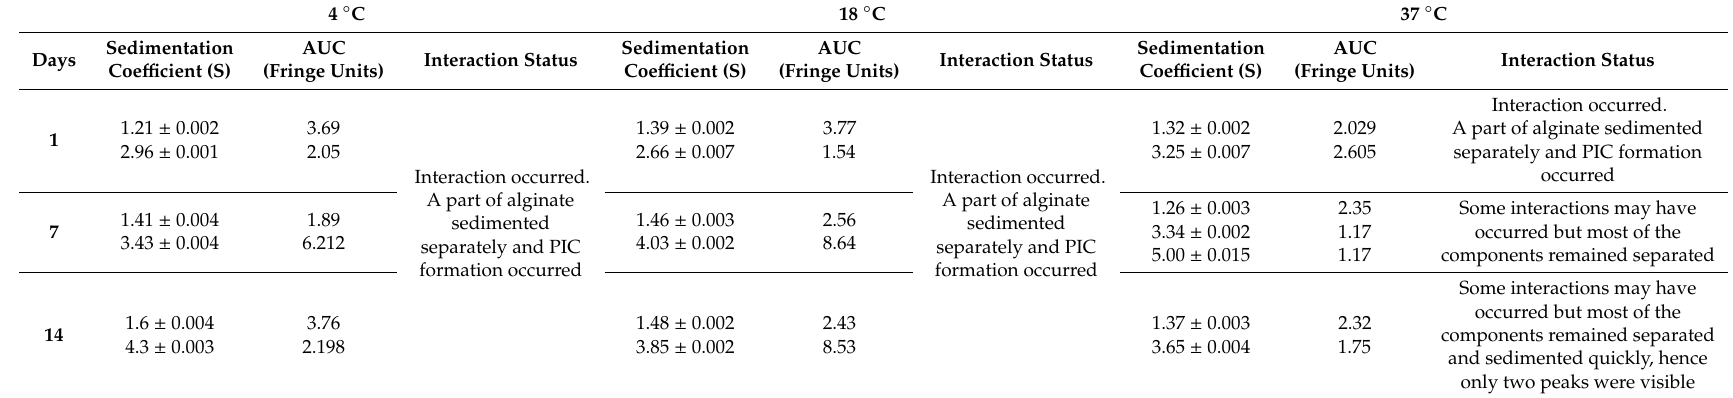
Table 3. Sedimentation coe ffi cient for PIC at pH 7.0, 50mM PBS at 4 ◦ C. Expected values area under curve for the peaks of X, A and IDeg Σ = 13.29, any value below 13.29 means stable complex